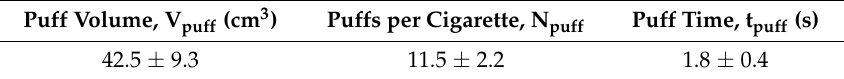
Table 2. Average data of human smoking patterns summarized by Zacny and Stitzer